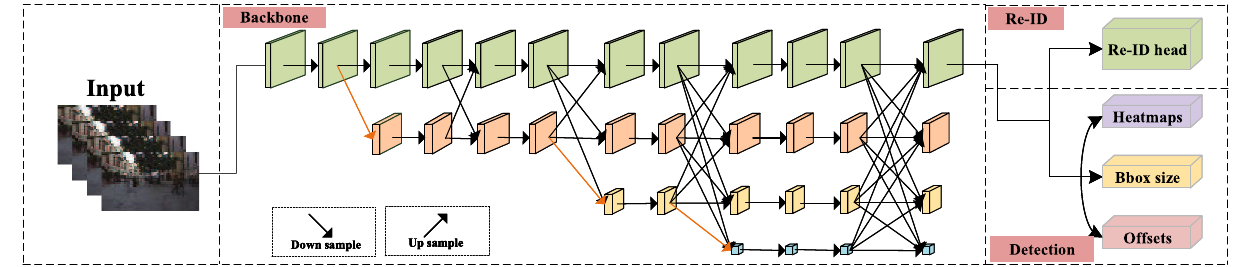
Figure 1. Overall network